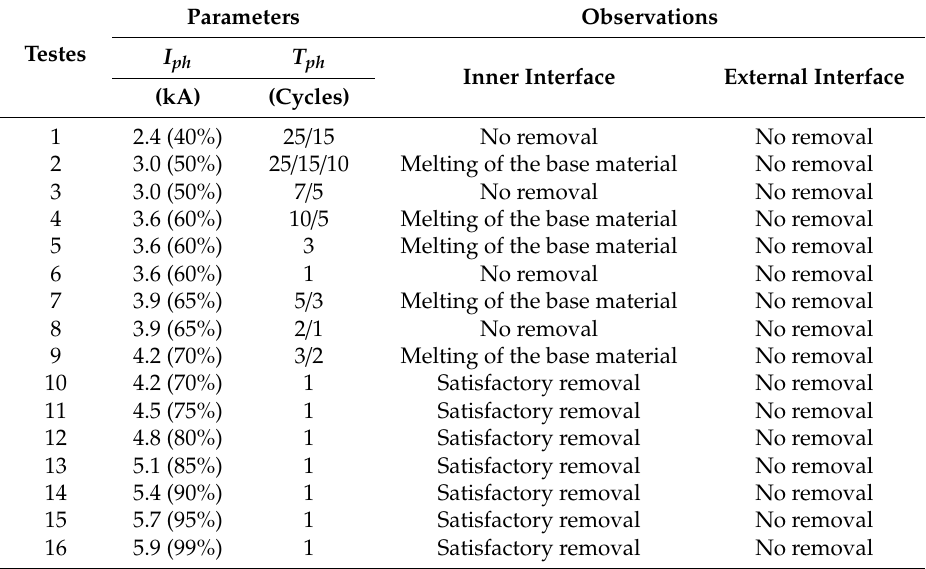
Table 5. Initial tests to define weld current and the pre-heating time.